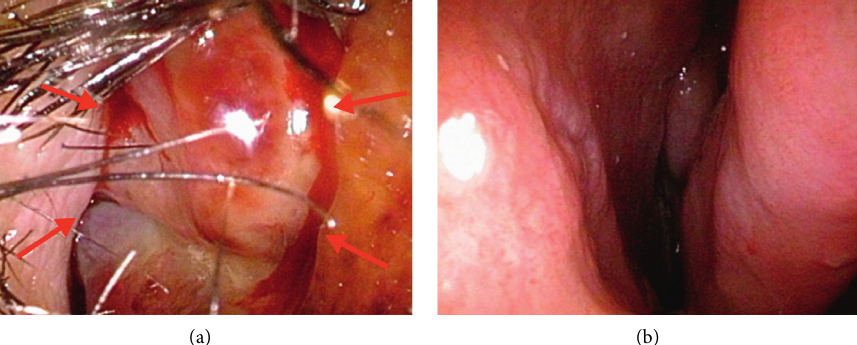
Figure 1: Endoscopic nasal examination revealed a granulomatous mass with an irregular surface in the anterior right nasal cavity (arrow). (a) Right side. (b) Left side.